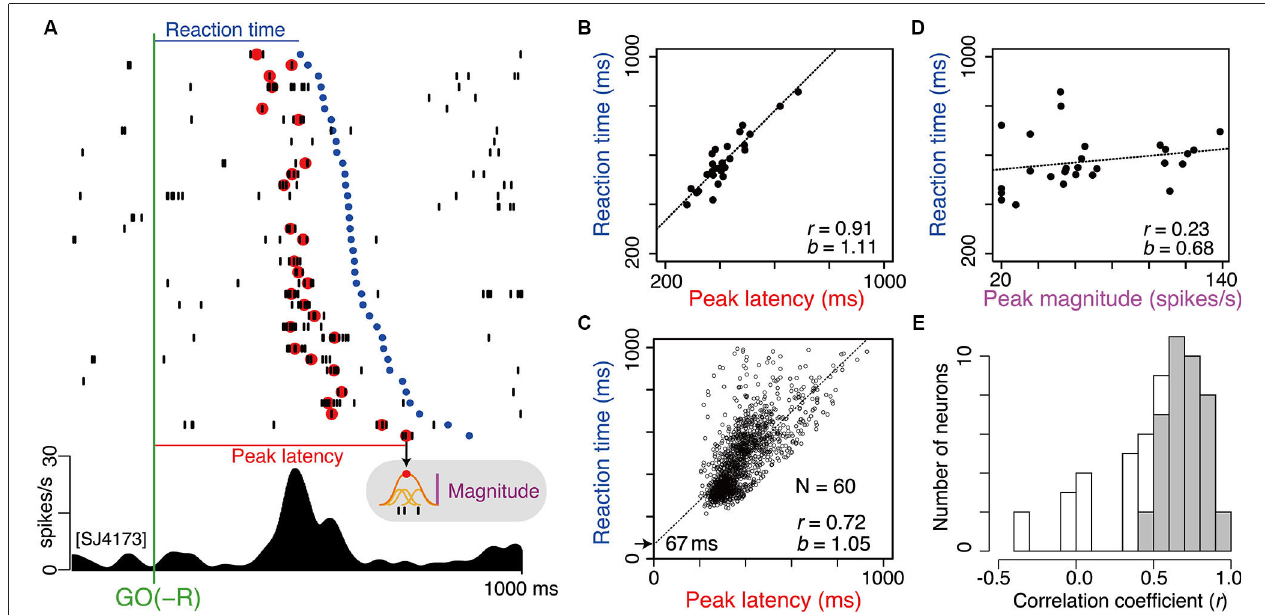
magnitude. (B) Relationship between peak latency of GO( − R) response and RT for the example neuron shown in A . (C) Same as B but for all significant GO( − R) responsive neurons ( n = 60). (D) Relationship between peak magnitude of GO( − R) response and RT for the example neuron shown in A . (E) Histogram of correlation coefficient between peak latency and RT. Gray bars indicate neurons with significant correlation coefficient ( p <